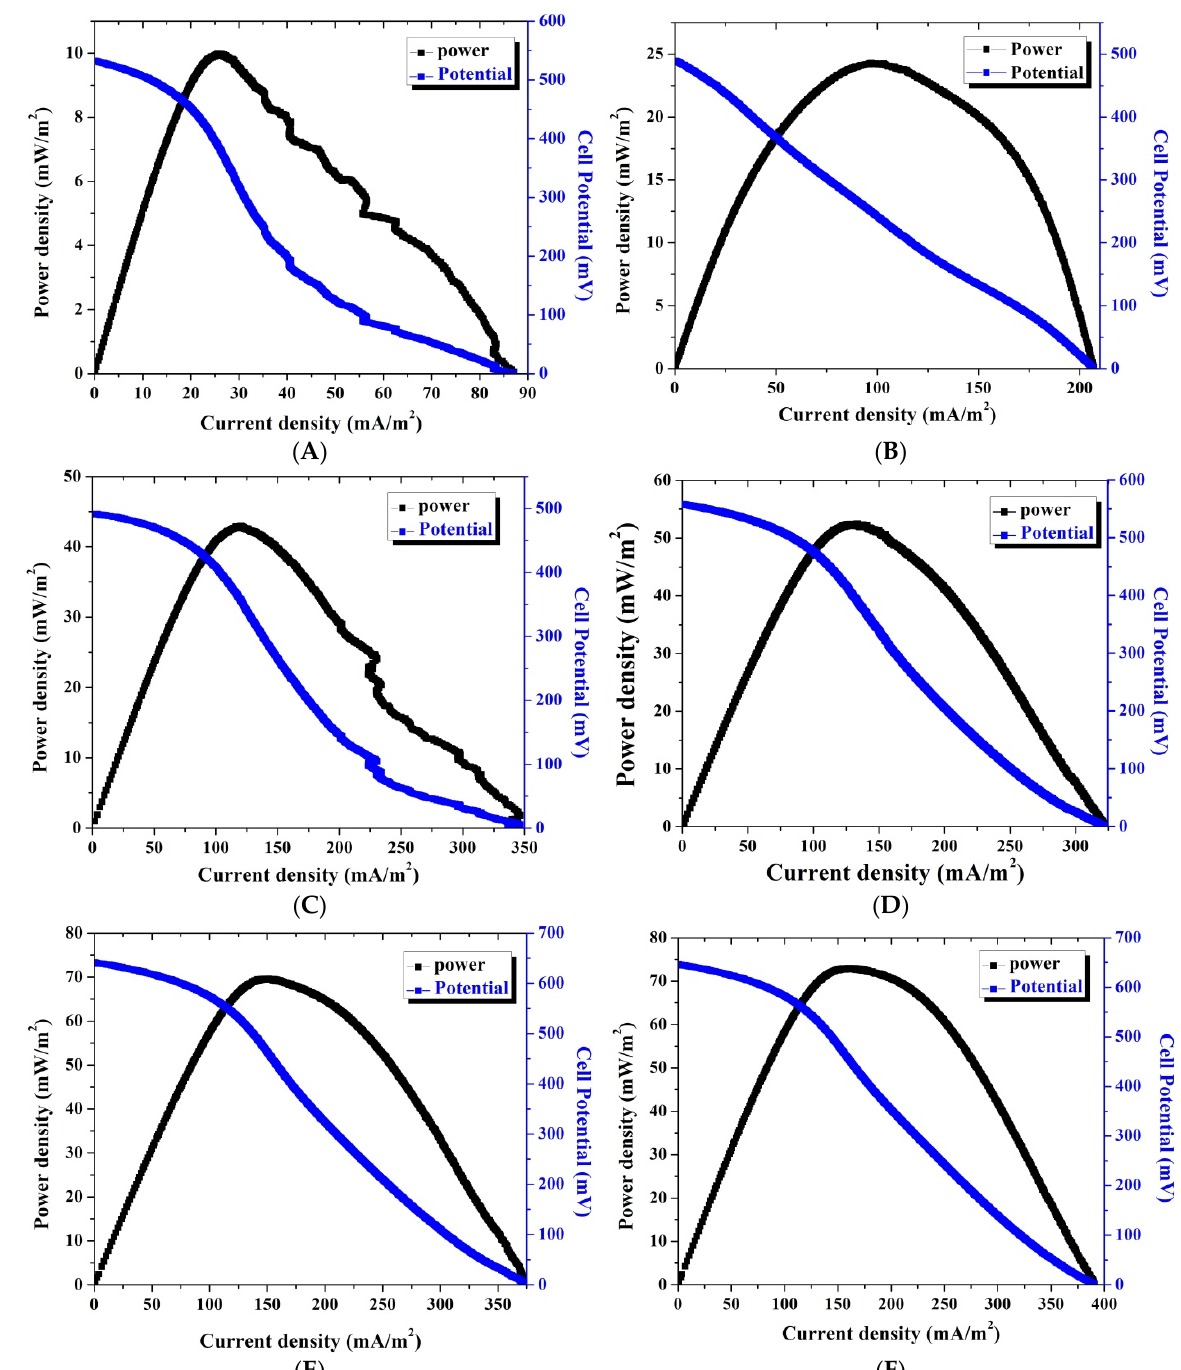
Figure 5. Polarization and power density curves of batch-mode and single-chamber MFCs using a single layer carbon nanofiber anode after 24: ( A ) 72; ( B ) 96; ( C ) 120; ( D ) 144; ( E ) and 168; ( F ) h batching time.